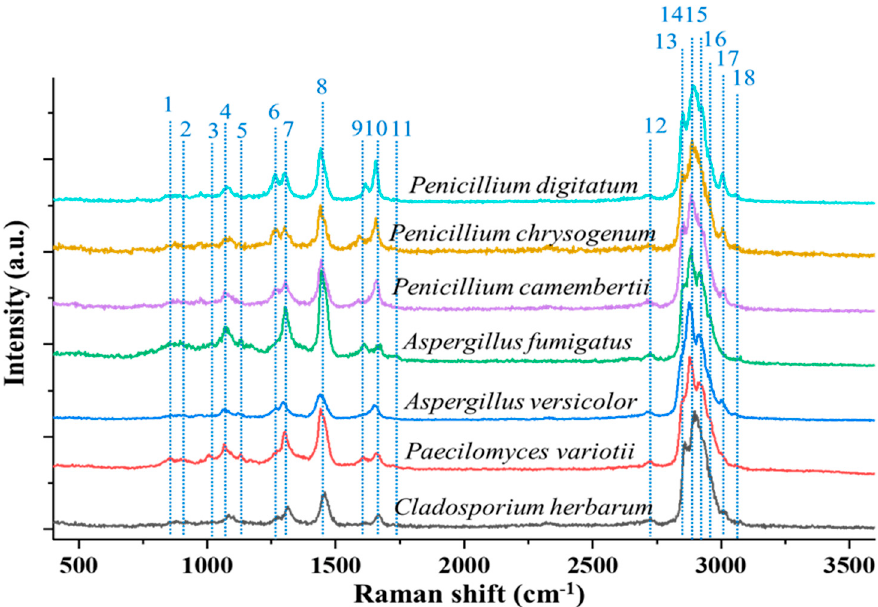
Figure 7. Raman spectra of various types of single, trapped fungi. (Reproduced with permission from ref. [51]. Copyright 2022, the Royal Society of Chemistry).